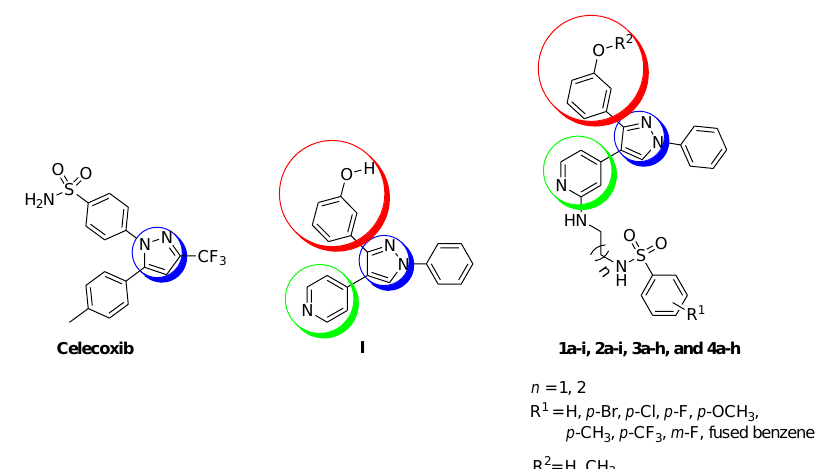
Figure 1. General structures of the target compounds, Celecoxib, and previously-reported pyrazole compound [40].